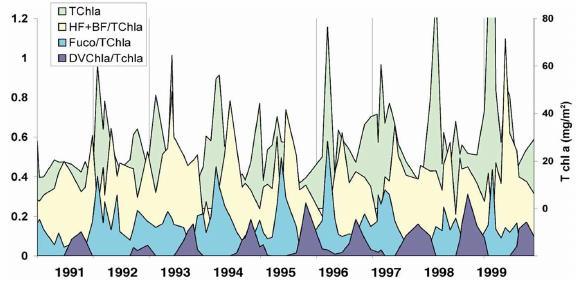
Fig. 9. Seasonal cycle of phytoplankton at the long-term station DYFAMED for the 1991–1999 period. Nanoflagellates (HF + BF), diatoms (Fuco) and Prochlorococcus (DVChl a ) are represented as ratio of their distinctive pigments to total chl a . The total chl a integrated concentration (mgm − 2 ) is also represented in green. Reproduced with permission from Marty et al. (2002).